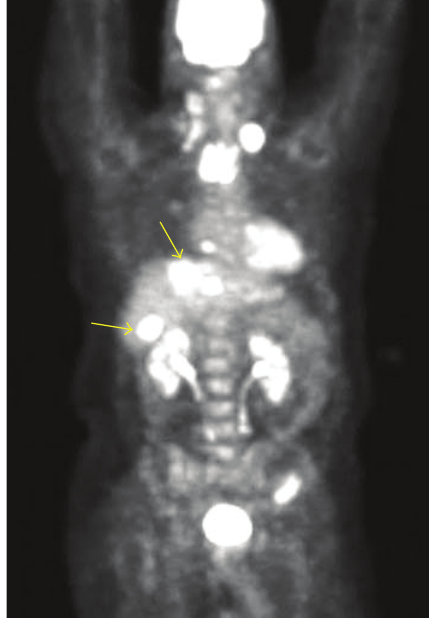
Figure 2: PET scan showing extensive uptake in the neck, chest and liver